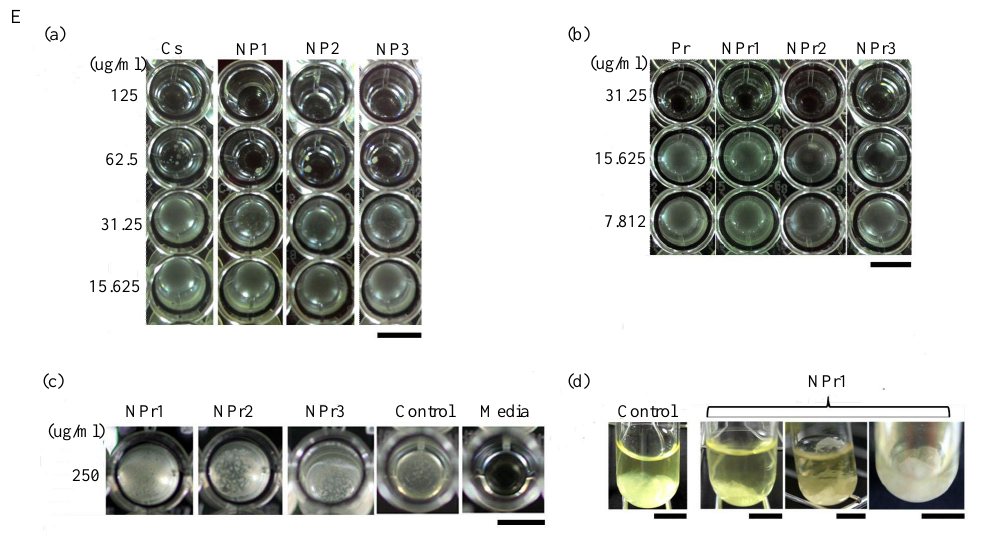
Figure 2. Inhibition of bacterial growth by chitosan nanoparticles (NP) against ( A ) B. cereus and ( B ) E. coli : C1 (125 µ g/mL), C2 (62.5 µ g/mL), C3 (31.25 µ g/mL), C4 (15.63 µ g/mL), C5 (7.81 µ